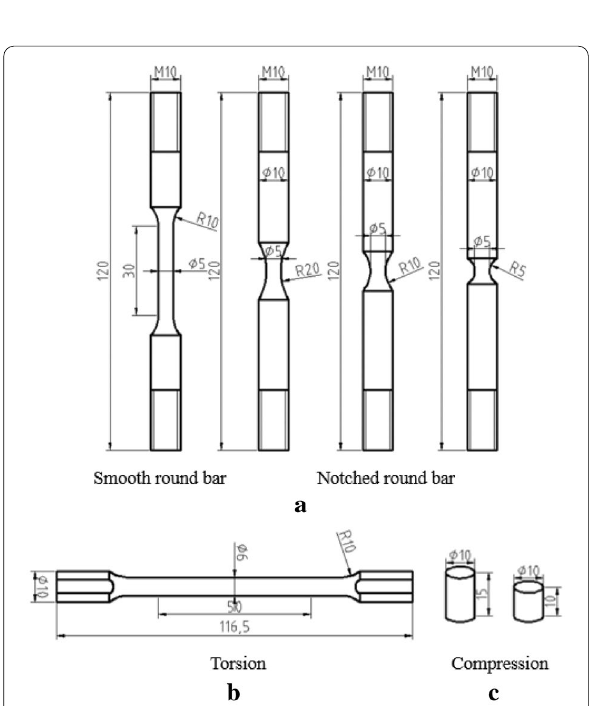
Figure 2 Shapes and dimensions of the samples of the room-temperature fracture tests: a SRB and NR tension test, b torsion test, and c compression